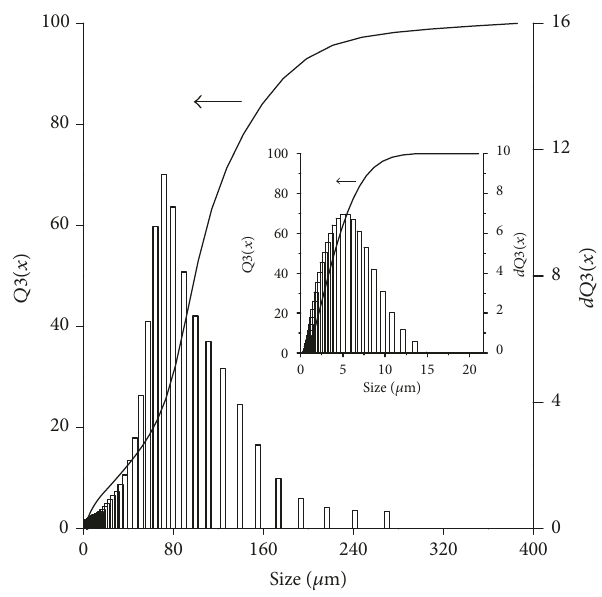
Figure 2: Profile and bar chart of particle-size distribution for the organobentonite powder and bentonite (in insertion).